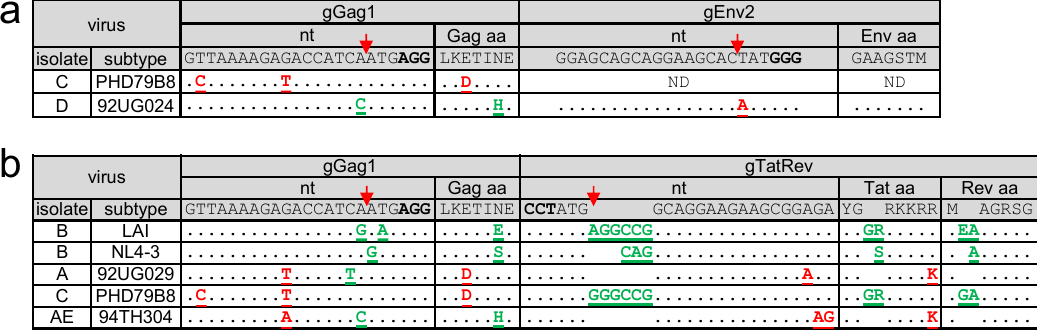
Figure 3. Sequence of the target region upon breakthrough virus replication. ( a–b ) When virus replication was observed in dual-gRNA expressing Jurkat cells (gGag1 + gEnv2 cells in a; gGag1+gTatRev cells in b), the viral target sequence was analyzed. The sequence fully complementary to the gRNA and the PAM (in bold), as present in the LAI isolate, are shown on top. The Cas9 cleavage site is indicated with a red arrow. For each isolate, the target sequence of the breakthrough virus is shown, with pre-existing gRNA-mismatching nucleotides indicated in red and newly acquired mutations observed upon replication indicated in green. The amino acid sequence of the encoded proteins is shown with the pre-existing and acquired amino acid differences indicated in red and green,